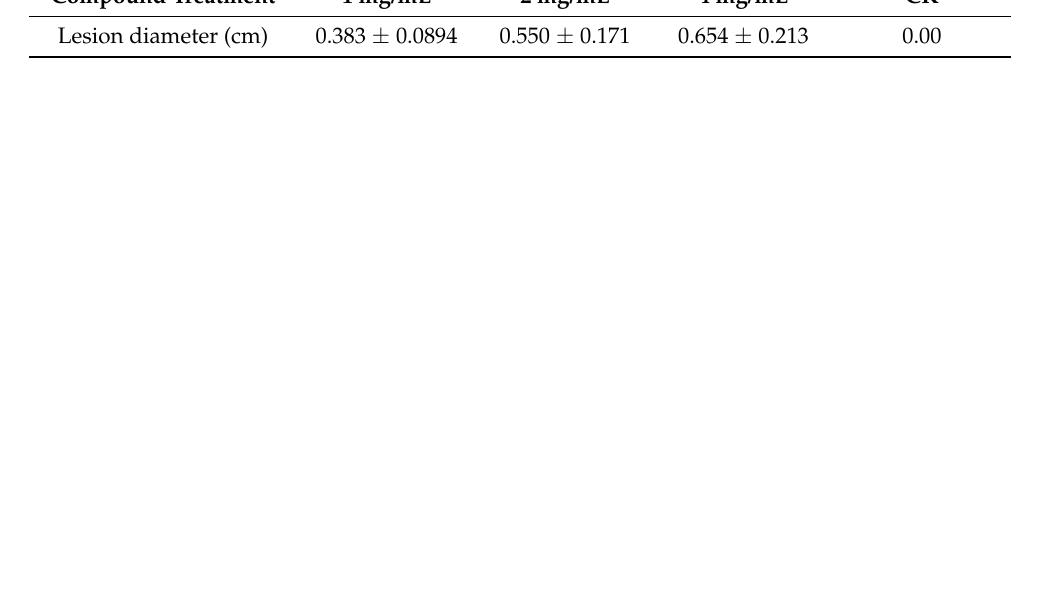
Table 3. The exogenous 3-MOPAA effect with different concentrations for lesion diameter. Compound